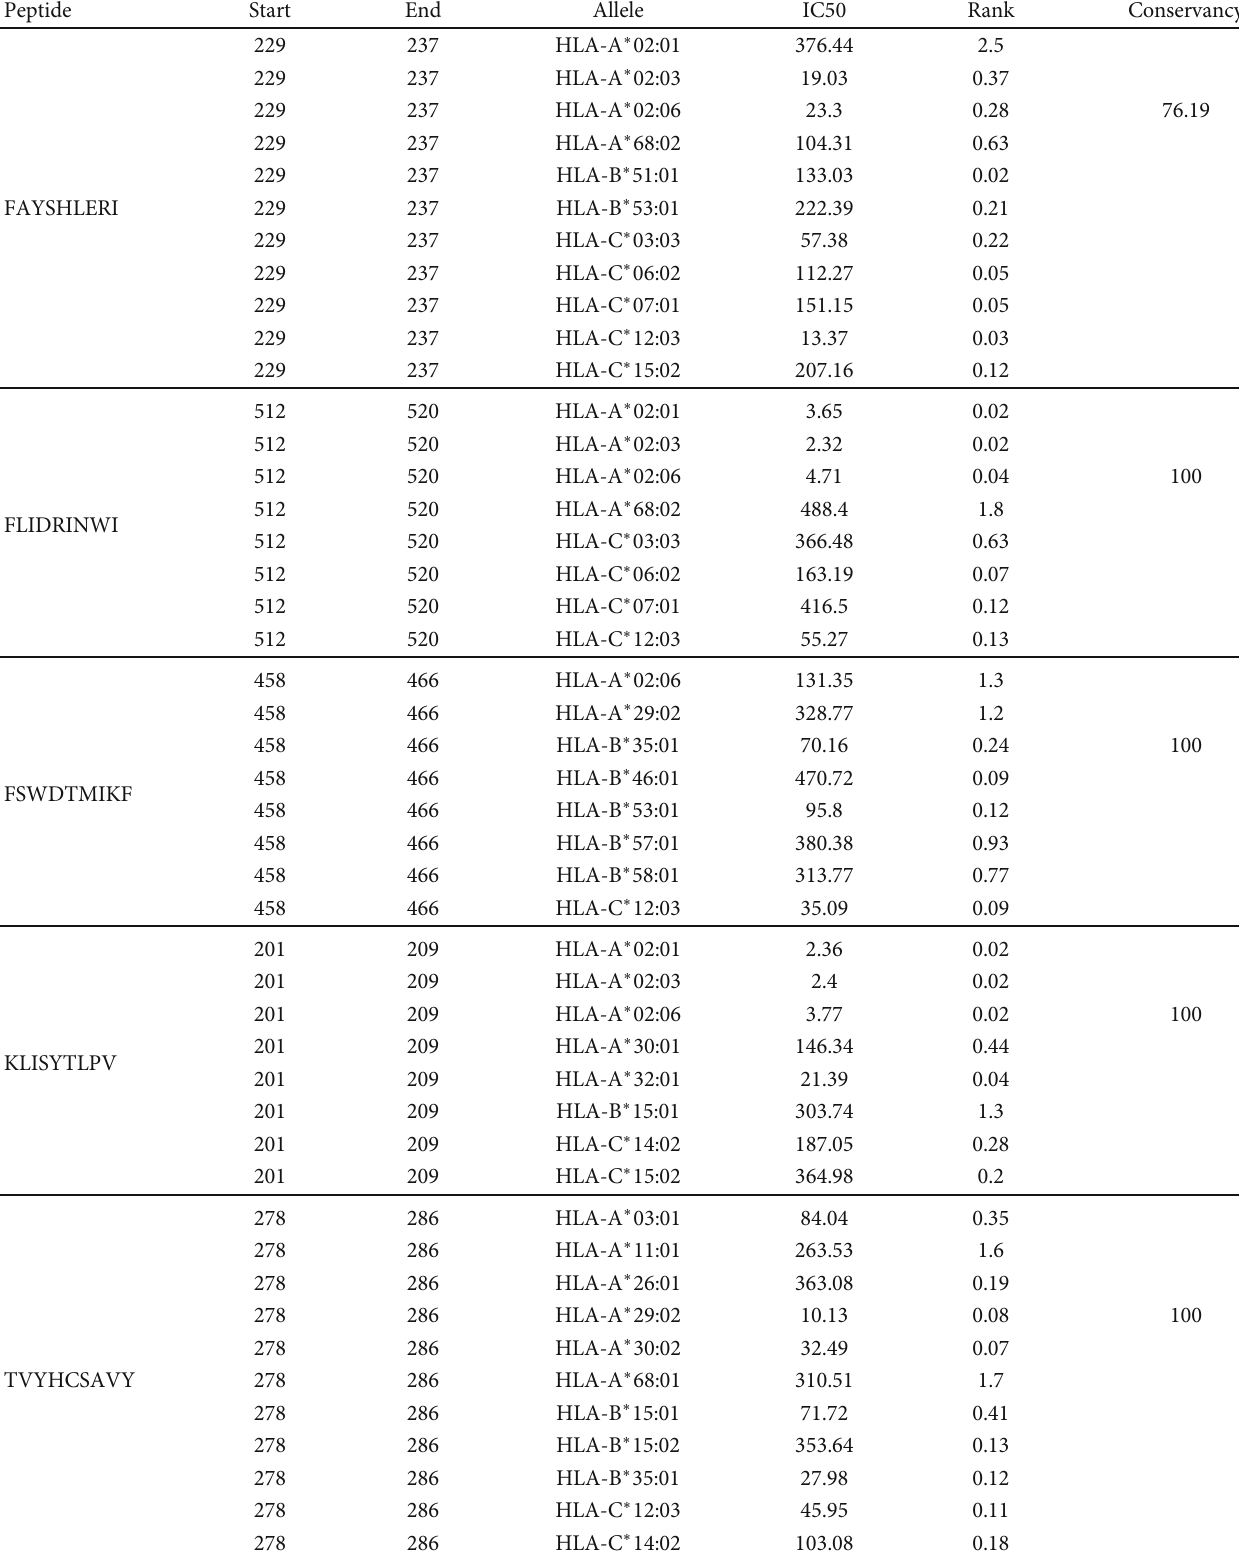
Table 2: Most potential T cell epitopes interacting with MHC class I alleles, their positions, IC50, rank, and conservancy.